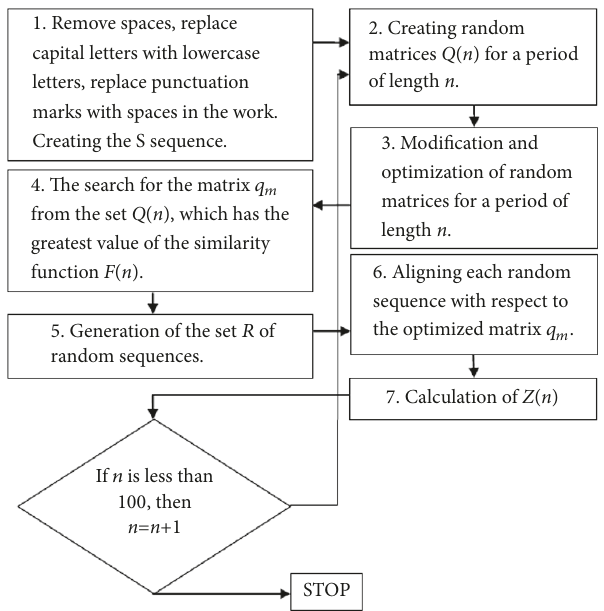
Figure 1: The main stages of the algorithm mused for calculation Z( n ) of the analyzed sequence S